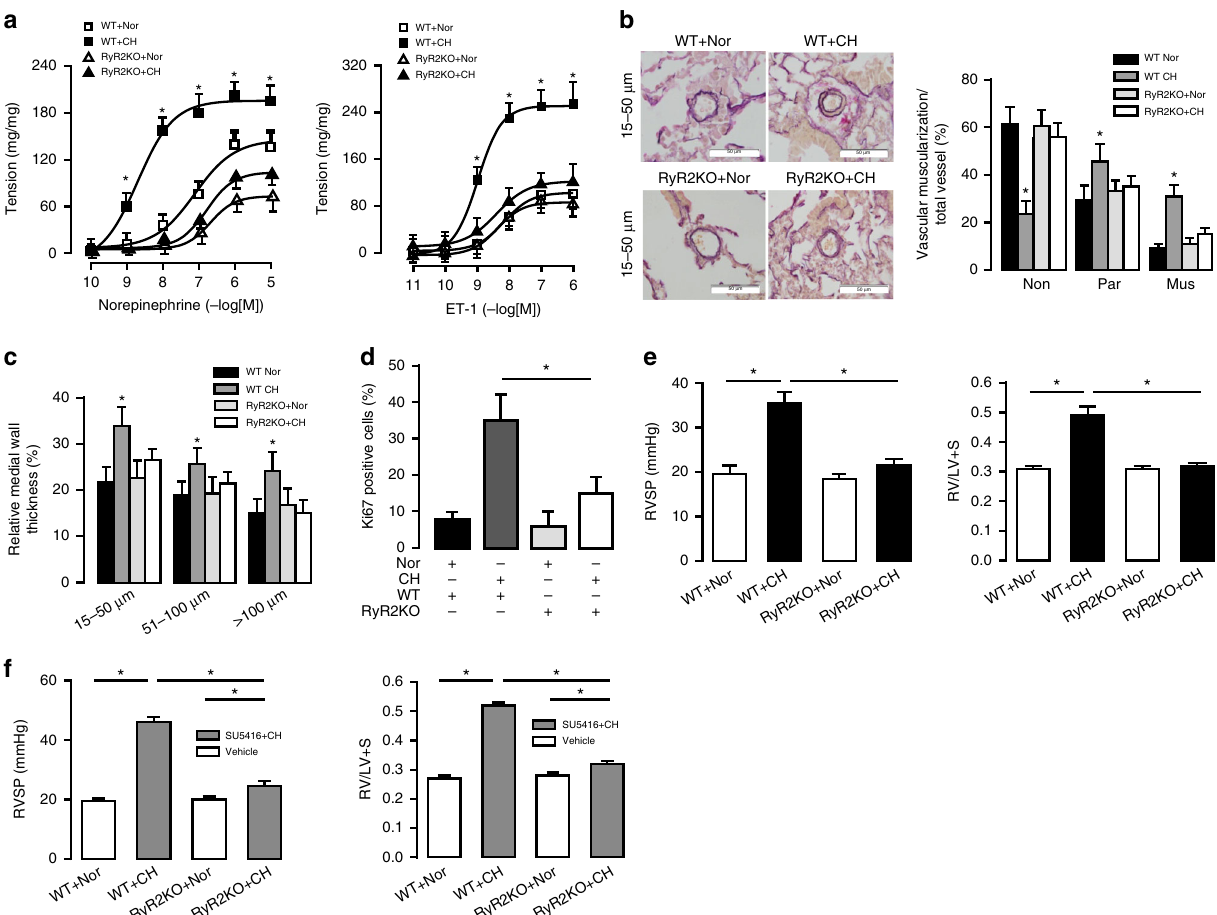
Fig. 2 RyR2 KO mice are resistant to hypoxia-induced pulmonary hypertension. a Concentration-response curves for norepinephrine and endothelin-1 (ET-1) induced muscle contraction are obtained from normoxic (Nor) and CH PA strips from WT and RyR2 KO mice ( n = 4 independent studies, 7 PA strips per study). b Typical lung sections of PAs are demonstrated by using Elastic Van Gieson staining in WT mice (bar scale: 50 µ m). Proportion of non- (Non), partially (Par), or fully (Mus) muscularized PAs in total counted PAs. A total of 50 – 60 intra-acinar vessels are analyzed in each mouse, and 5 – 7 mice have been grouped ( n = 5 independent studies, 50 vessels per study). c Relative medial wall thickness of PAs sized 15 – 50 μ m, 51 – 100 μ m, and over 100 μ m in relation to cross-sectional diameter ( n = 5 independent studies, 50 vessels per study). d PASMC proliferation (Ki-67 staining) in vivo after CH. The degree of cell proliferation is expressed as the percentage of Ki-67-labeled cells over the total number of cells counted in the media layer of at least 20 muscularized vessels per mouse ( n = 5 independent studies, 50 vessels per study). e Summarized the effect of chronic hypoxia (CH) on the right ventricular systolic pressure (RVSP) in WT and RyR2 KO PH mice model measured by 1.2 F catheter. Ratio of right ventricle (RV) to left ventricle (LV) plus septum (S) weight (RV/LV + S) to measure RV hypertrophy ( n = 6 independent studies, 5 mice per study). f Effect of SU5416 subcutaneously once weekly (20 mg/kg) or vehicle followed by CH on WT RVSP and RV/LV + S ( n = 5 independent studies, 5 mice per study). Data are expressed as mean ± standard error. (* P < 0.05, using one-way ANOVA